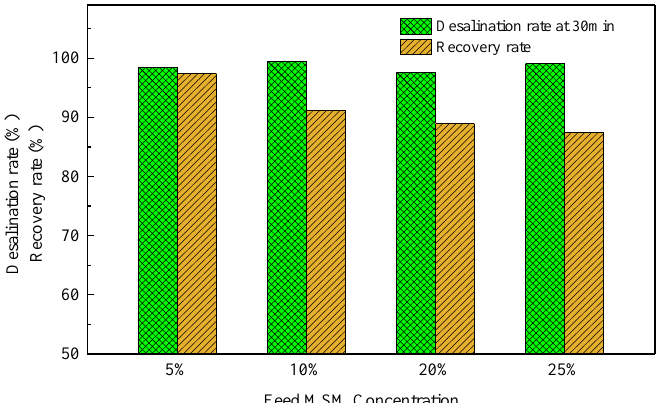
Figure 6. The desalination ratio and recovery ratio under different concentrations of MSM. The NaNO 3 concentrations were 0.17%, 0.35%, 0.70%, and 0.83%, respectively, when the MSM concentrations were 5%, 10%, 20%, and 25%.